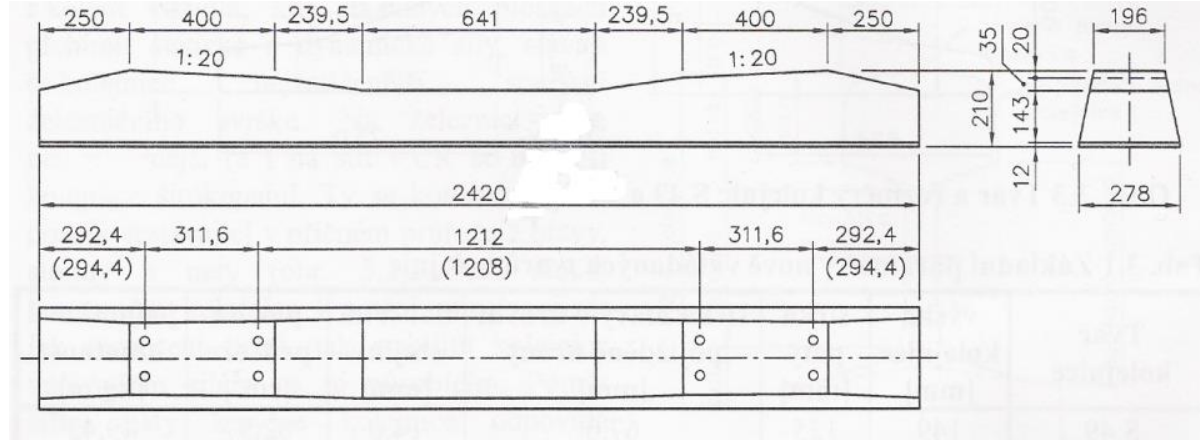
Figure 7. The concrete sleeper [mm].